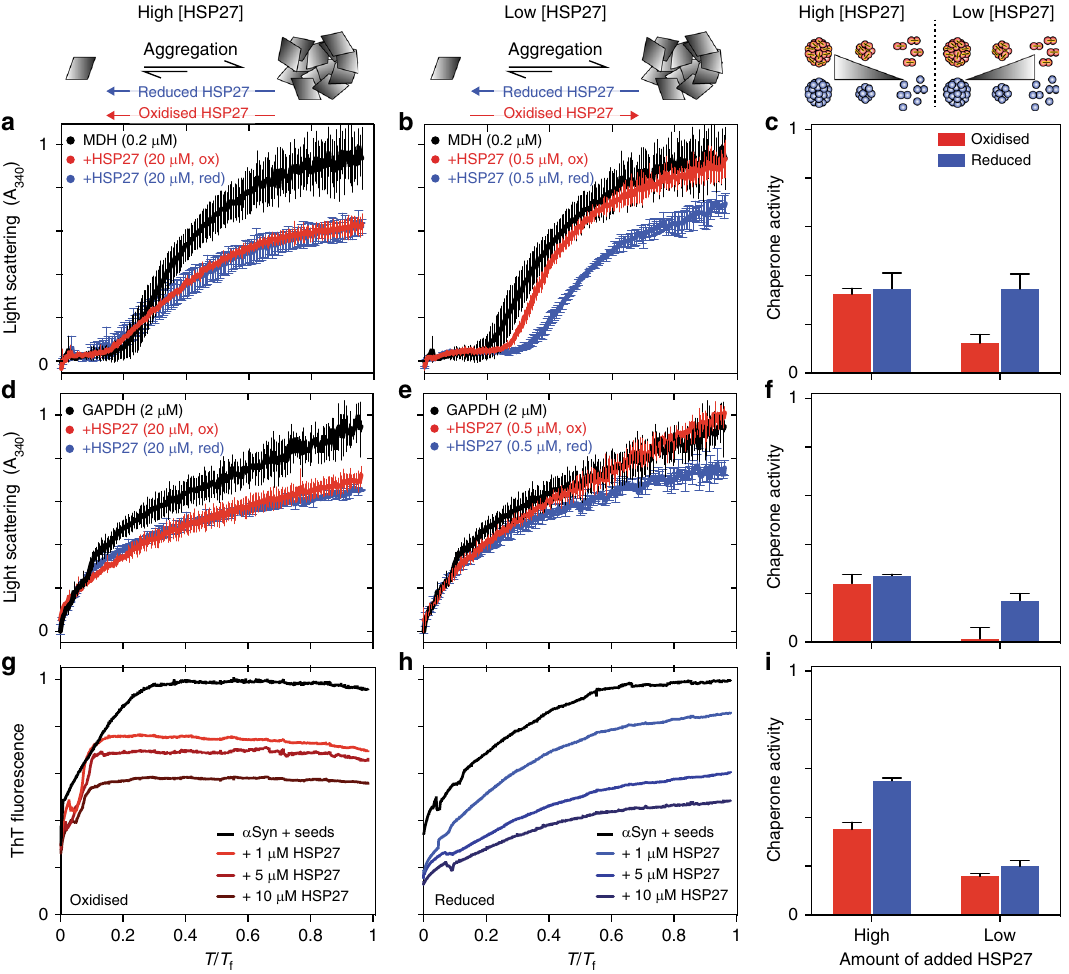
Fig. 2 HSP27 monomers are potent chaperones in vitro. The aggregation of MDH ( a , b ) and GAPDH ( d , e ) was monitored by light scattering at 340 nm and seeded amyloid fi bril formation by α S ( g , h ) was monitored by ThT fl uorescence. Reduced (blue) or oxidised (red) HSP27 was added at either high ( ≥ 10 μ M) concentrations ( a , d , g ) where it is predominantly oligomeric or low ( ≤ 1 μ M) concentrations ( b , e , h ) where a large fraction of dimers (oxidised) or monomers (reduced) are populated. The y axes were normalised for comparison, and the x axes were scaled by a factor T f to normalise time. The T f values used for each substrate were 5 ( a , b ), 5 ( d , e ), and 170 ( g , h ). The chaperone activity of HSP27 against each substrate ( c , f , i ) is quanti fi ed as one minus the ratio of average signal over the time course with and without chaperone (Methods). Values of one and zero would respectively represent the complete inhibition of aggregation and no protection against aggregation. The average of three replicates is shown with error bars corresponding to ±1